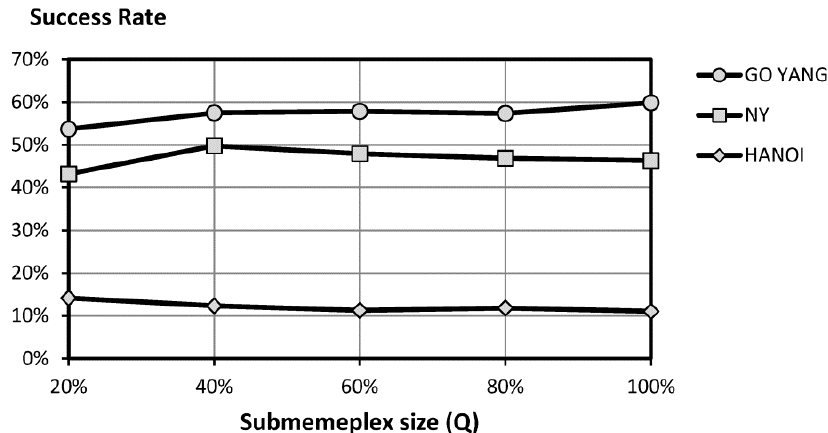
Figure 7. Success rate based on the submemeplex size ( q ).